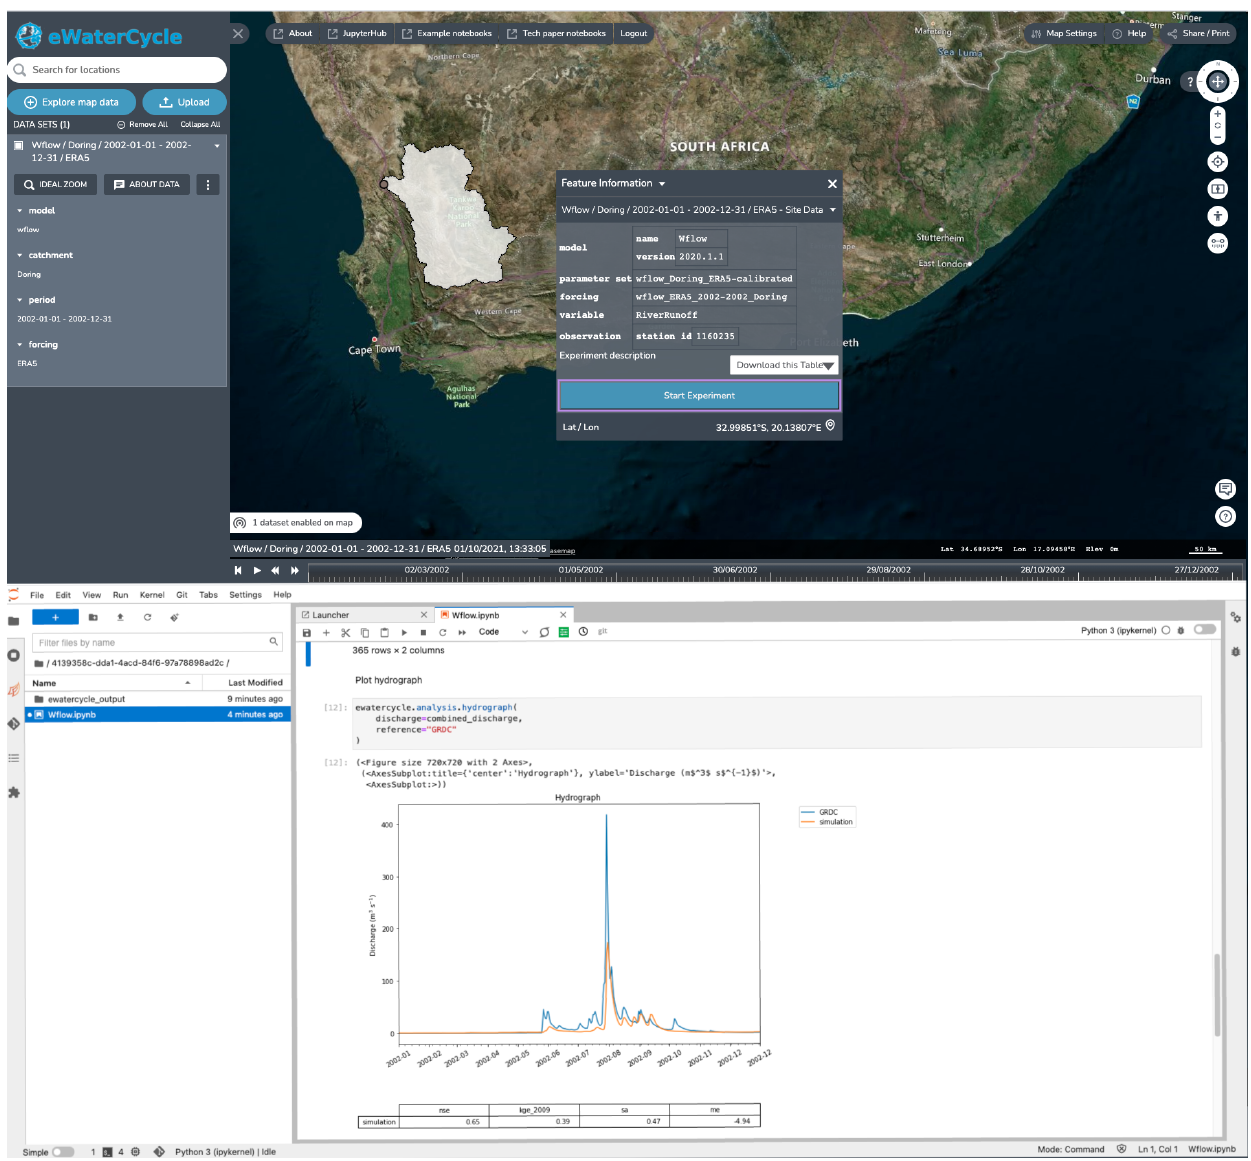
Figure 4. The notebook generator, which generates a notebook based on the experimental setup configured in the explorer. After selecting a model and clicking “start experiment”, a Jupyter notebook is generated and started up that has all the code to, when run, generate a hydrograph for the selected model in the selected region. By providing this working notebook, researchers have a good starting point to change the notebook to answer their own research questions. Background maps are © Microsoft Bing Maps 2018 screen shot(s) reprinted with permission from the Microsoft